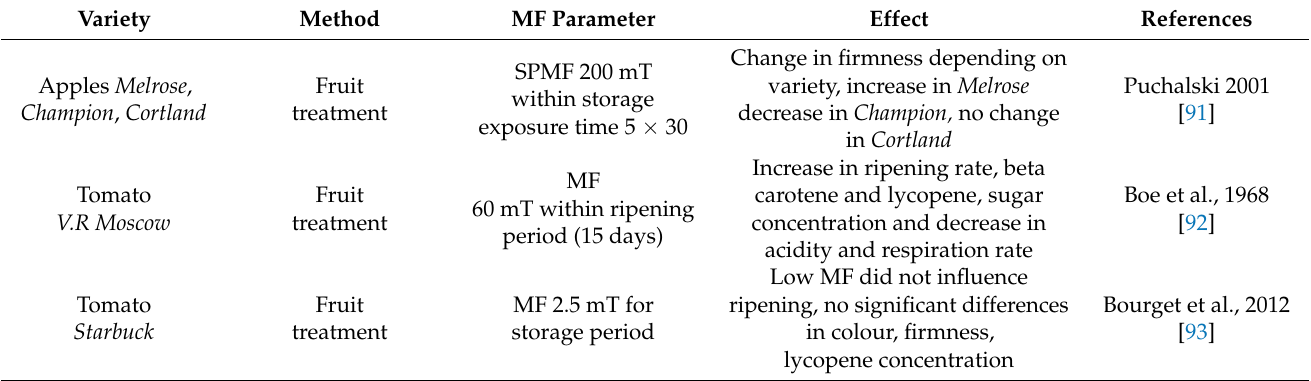
Table 2. Summary of the total effect of magnetic fields and electrical fields on the ripening and shelf life of